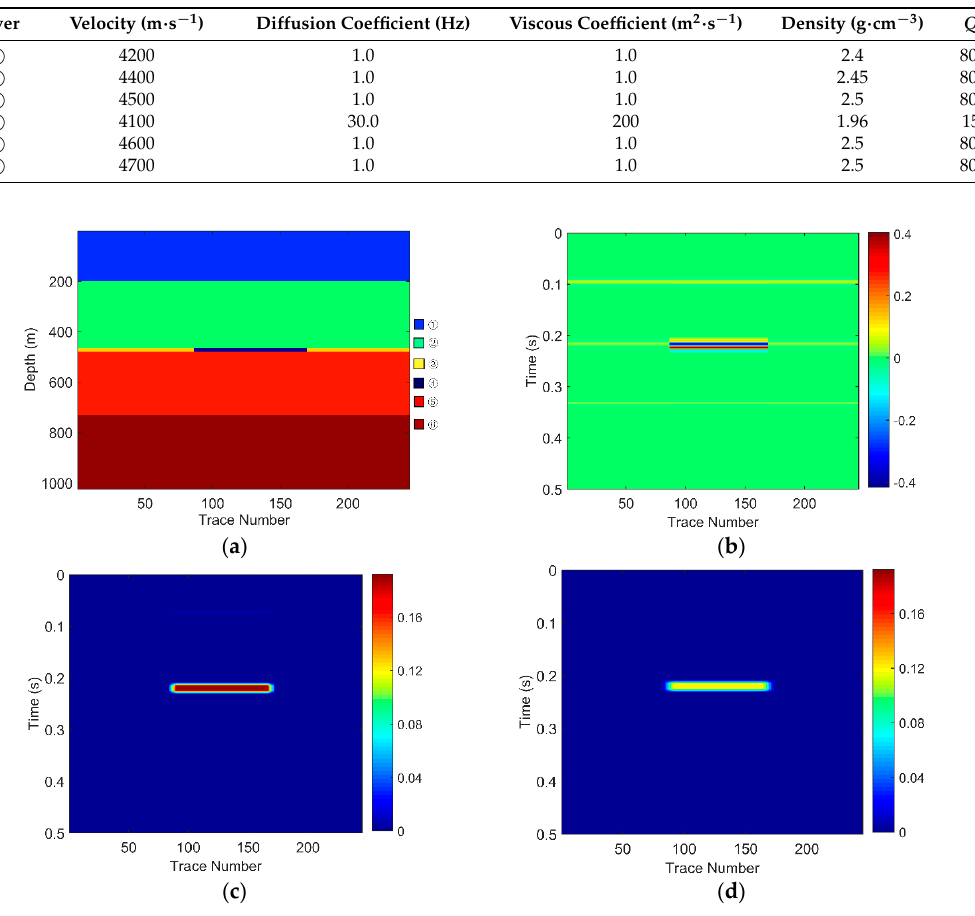
Figure 3. For Geological Model 1: ( a ) the gas-bearing layer is 15 m; ( b ) the seismic response; ( c ) the low frequency section; and ( d ) the high frequency section.